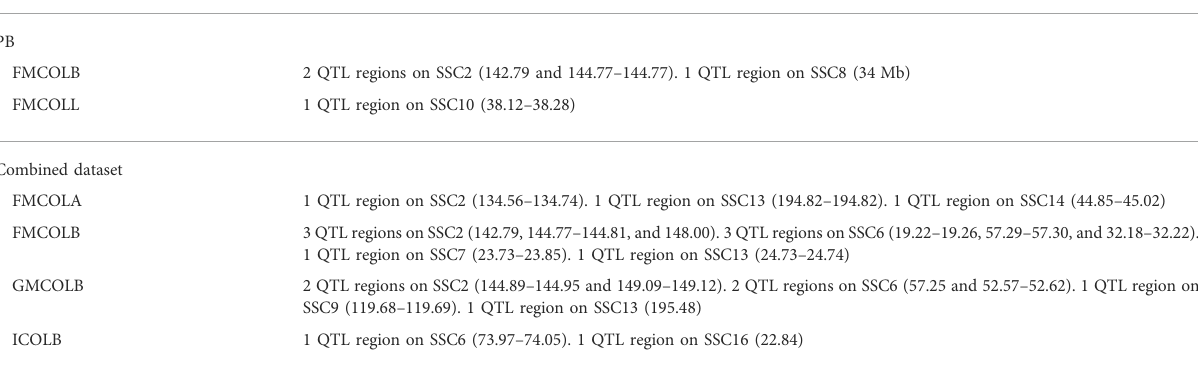
TABLE 8 Novel genomic regions detected by WGS in PB pigs and in Combined dataset (combined CBs and PBs). Trait Number of QTL regions and their genomic region in mega base pairs